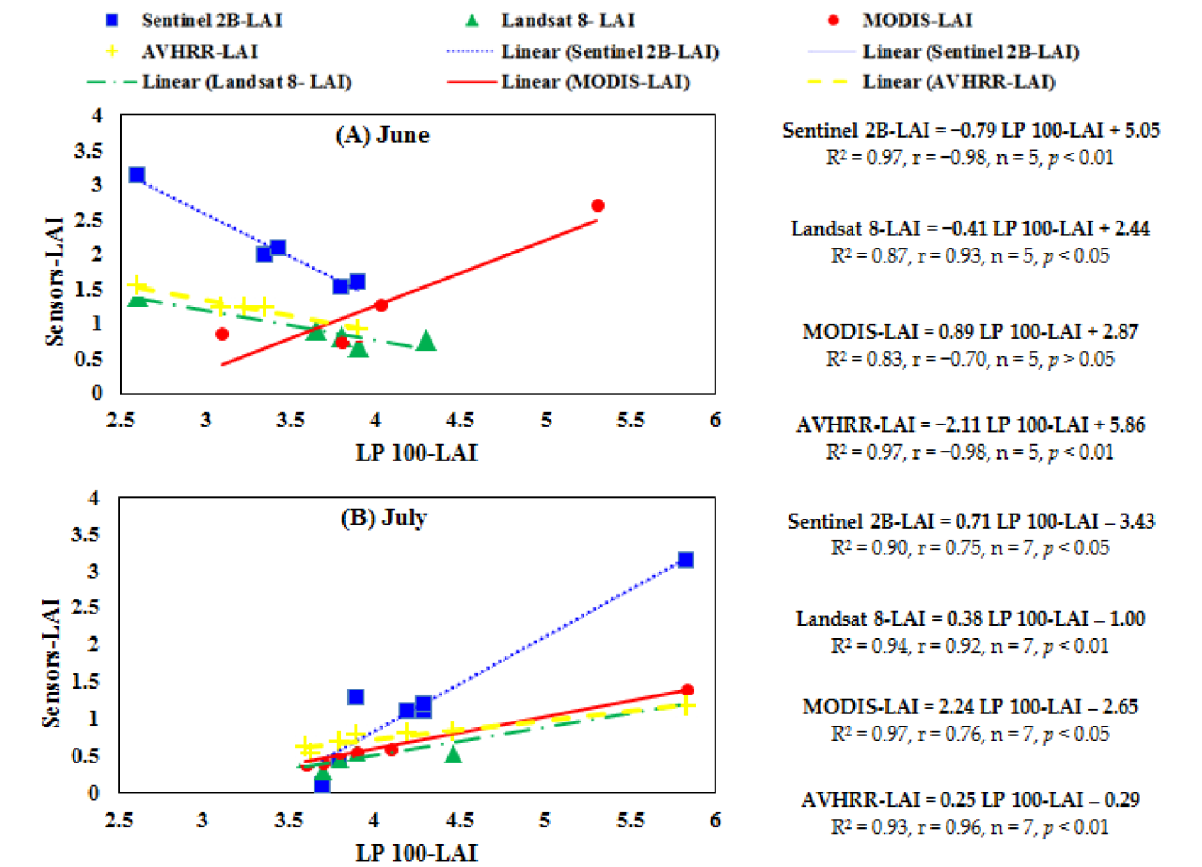
Figure 6. Comparison of LP 100 and estimated LAI using Sentinel-2, Landsat 8, MODIS, and AVHRR in June ( A ) and July ( B ) 2020. Table 5. Accuracy assessment results for sampling months, PFTs, and different